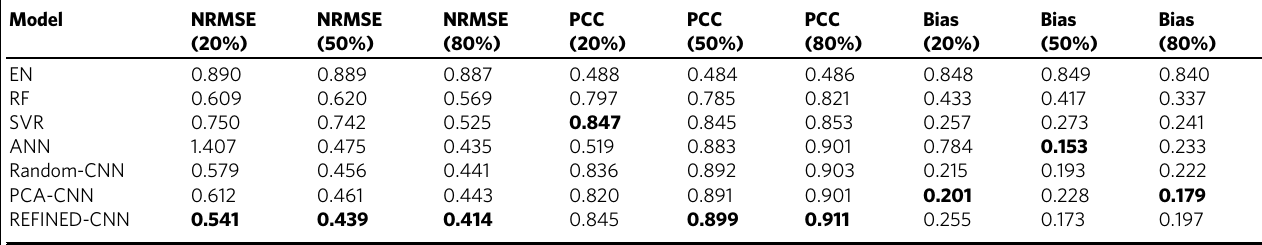
Table 2 REFINED-CNN performance comparison with competing models for the GDSC dataset. Model